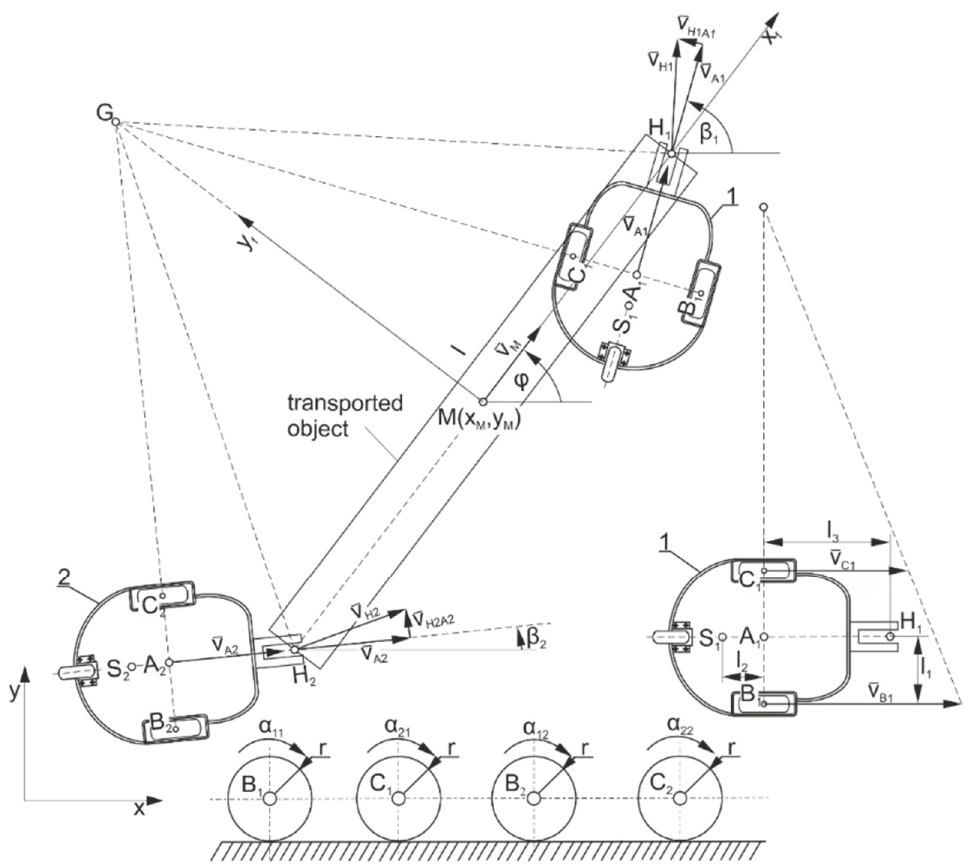
Figure 1. Diagram of the formation of robots transporting the beam.